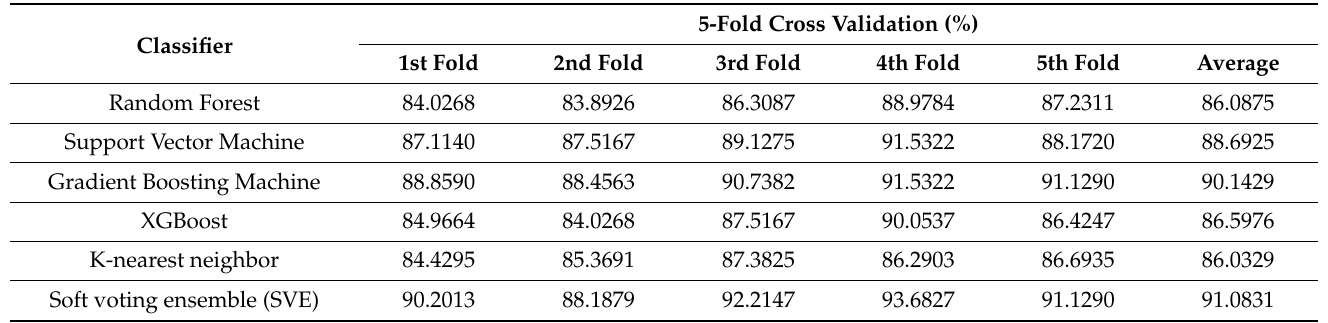
Table 4. Five-fold cross